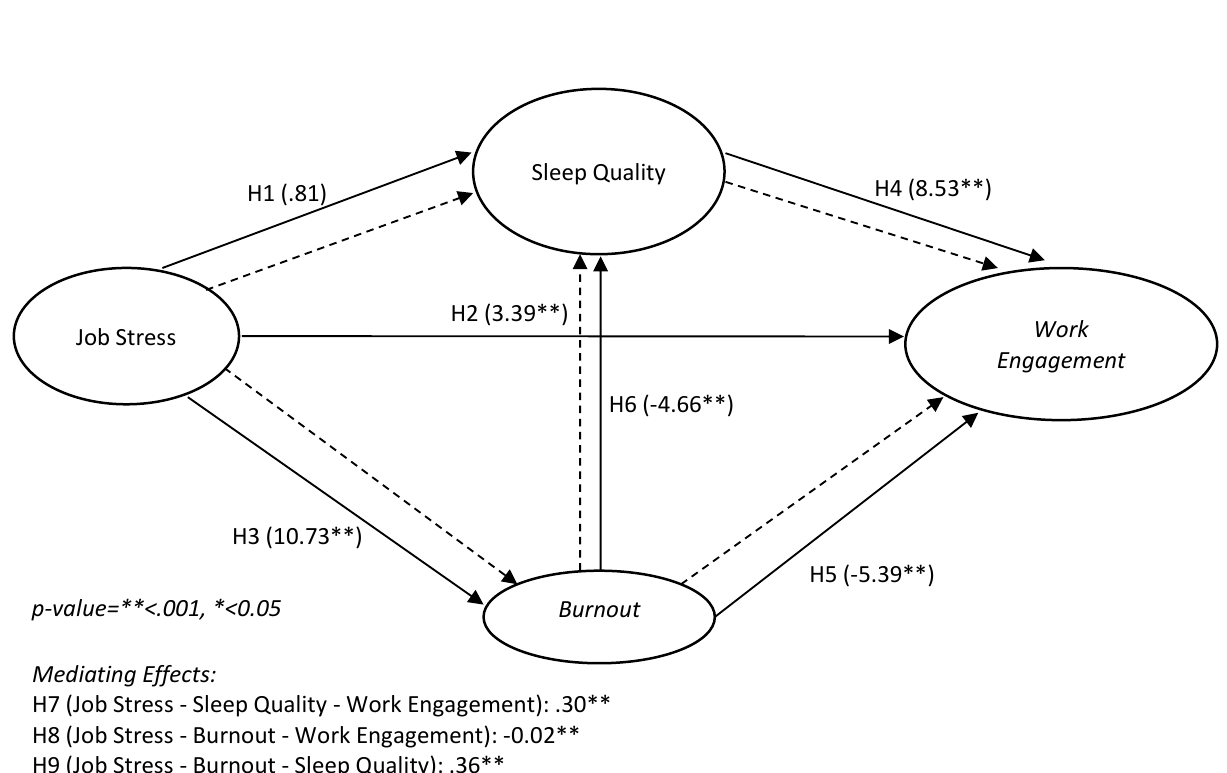
Figure 1. Research Model and